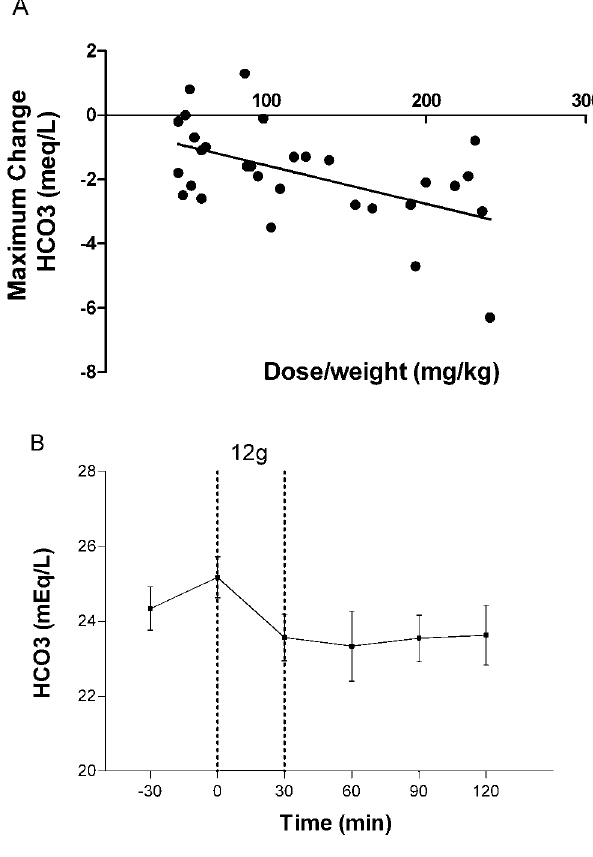
Figure 3. Effects of L-arginine hydrochloride infusion on venous blood bicarbonate concentrations. Figure 3A: Relation- ship between dose/weight (mg/kg) of infused L-arginine and the maximal decrease in venous blood bicarbonate concentration at any time during or in the two hours following infusion (n=30; r= 2 0.53, p=0.003). Figure 3B: Venous blood bicarbonate concentrations of patients before and after 30 minute administration of the highest dose of L-arginine (12 g; n=10). Shaded area indicates time of L-arginine infusion. Dots and bars indicate mean 6 SEM.